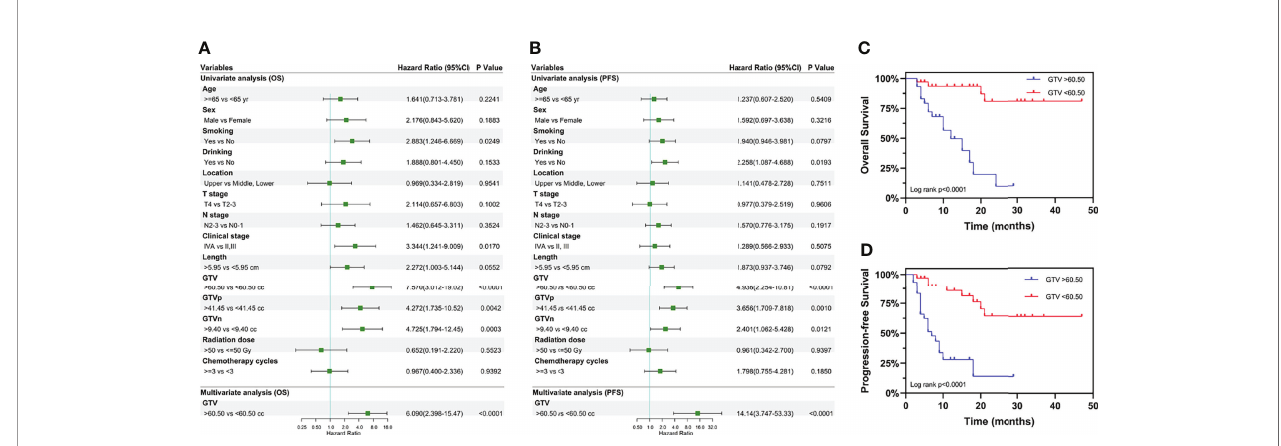
FIGURE 3 | Univariate and multivariate analyses of overall survival and progression-free survival. Results of the univariate and multivariate analyses of the GTV effect on (A) overall survival and (B) progression-free survival. Kaplan-Meier curves for overall survival (C) and progression-free survival (D) strati fi ed by GTV. Hazard ratios and 95% con fi dence intervals for death in the group with GTV > 60.50 cc, compared to the group with GTV < 60.50 cc. GTV, gross tumor volume; GTVp, gross tumor volume of primary; GTVn, gross tumor volume of lymph nodes; HR, hazard ratio; CI, con fi dence interval; cc, cubic centimeters.